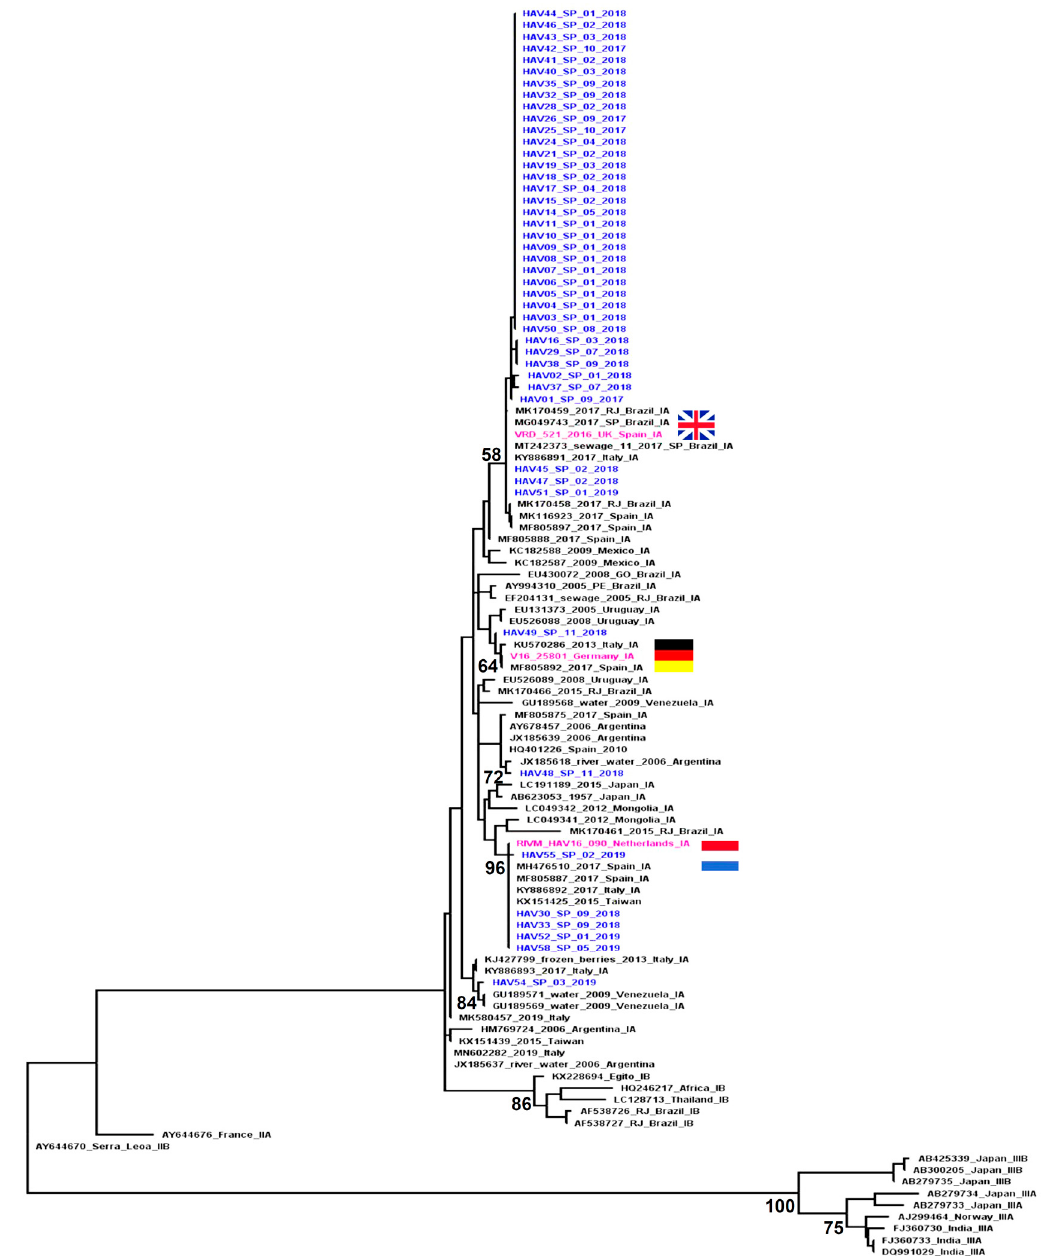
Figure 1. Phylogenetic tree of VP1/2A sequences (267 bp) from HAV strains isolated from acute hepatitis A cases identified in São Paulo city, Brazil, during 2016–2019. The analysis included 105 sequences: 45 from this study (in blue and identified with the sample number followed by the region, month and year of collection) and 60 reference sequences obtained from GenBank (identified with the accession number followed by the geographical origin and subgenotype). The reference clusters of HAV sequences isolated during the outbreak observed in European countries are highlighted in pink: VRD_521_2016 (United Kingdom), RIMV-HAV16-090 (Amsterdam, The Netherlands) and V16-25801 (Germany). Bootstrap values are shown along each main branch.